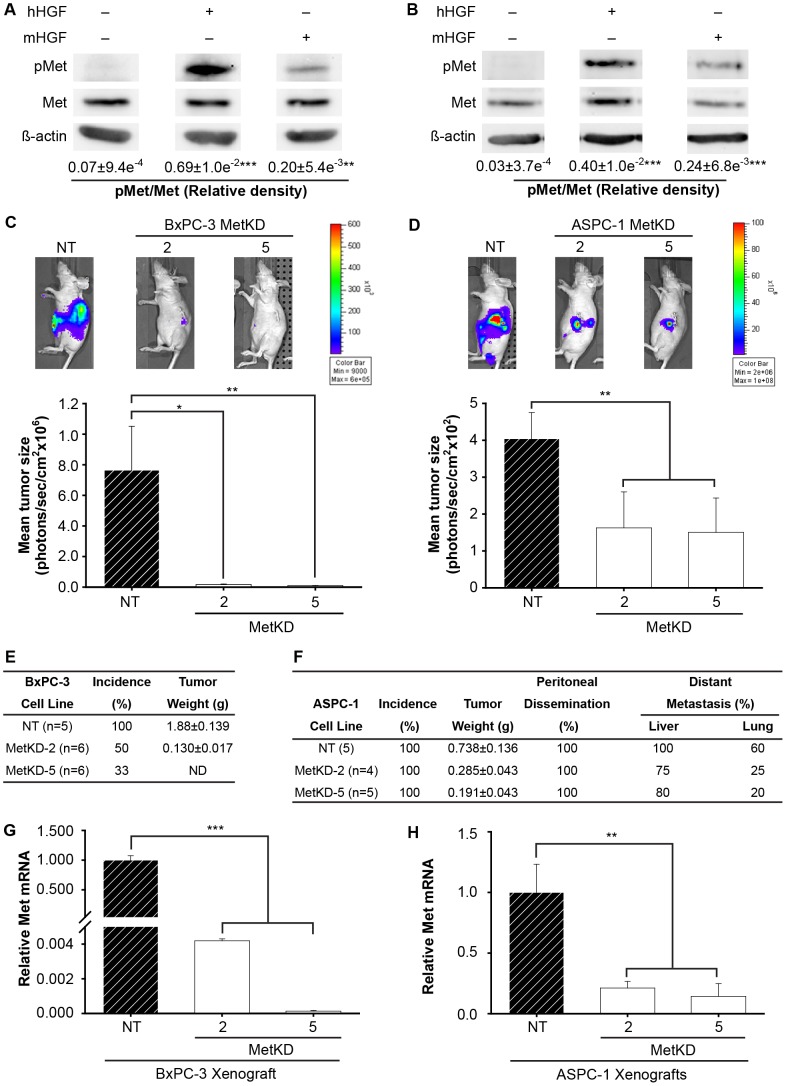
Met impairs in vivo tumor burden.Western analysis confirmed that murine (mHGF) and human HGF (hHGF) activate human Met in BxPC-3 (A) and ASPC-1 (B) NT cell lines. No Met activation was observed in the absence of ligand. Values are expressed as mean relative density of pMet/Met +/− SEM (**p<0.01 ***p<0.001; ANOVA, two separate experiments). Tumor size was measured every 10 days using in vivo bioluminescent imaging for BxPC-3 (C) or ASPC-1 (D) cells post injection and are reported as mean tumor size in photons/sec/cm2 (*p<0.05, **p<0.01; ANOVA). Representative bioluminescent images are shown immediately prior to necropsy at 30 days (BxPC-3) or 45 days (ASPC-1). The weight and overall incidence (%) of BxPC-3 primary tumors (E) and ASPC-1 (F) primary and metastatic tumors are listed. Stable knockdown of Met mRNA in BxPC-3 (G) and ASPC-1 (H) MetKD xenografts was confirmed using qRT-PCR. Data were normalized to GADPH and are reported relative to the respective NT control (**<p0.01; ***p<0.001; ANOVA, n = 2).